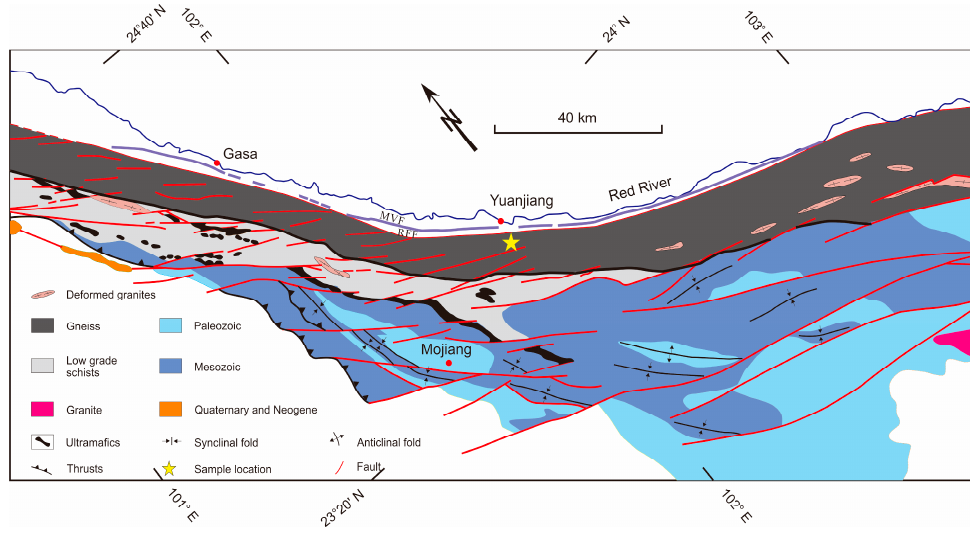
Figure 2. Structural map of Ailao Shan metamorphic range (modified after Leloup et al. [7]): MVF—mid-valley fault; RFF—range front fault.